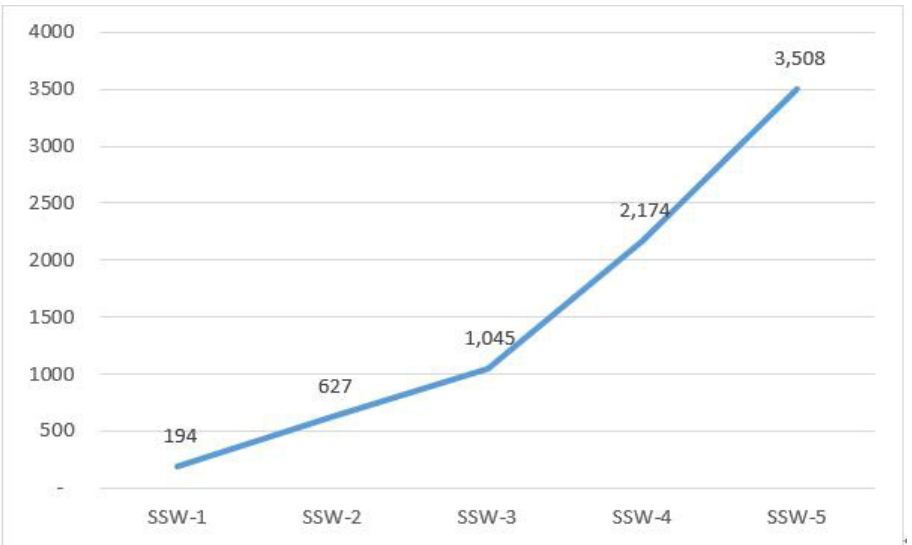
Figure 5. Numbers of buildings (grouped by type) affected by flooding at each SSW level.